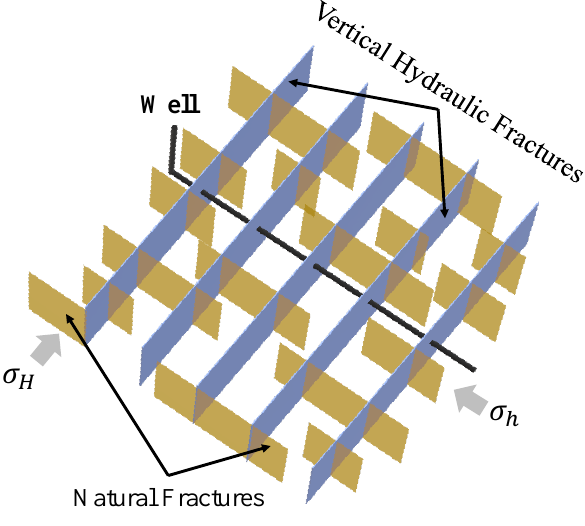
Figure 7. Schematic figure of an orthogonal fracture network. Adapted from: